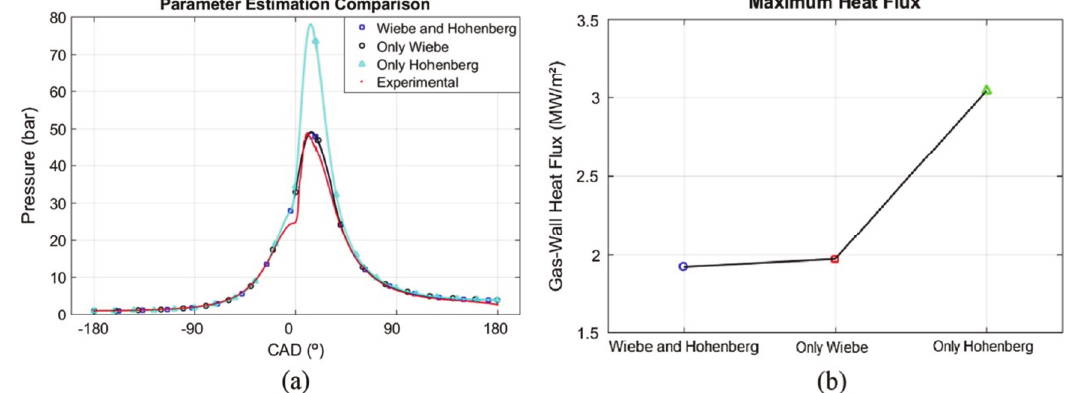
Fig. 6. Three cases estimation comparison using Hohenberg’s correlation for (a) the in-cylinder pressure and (b) the maximum heat flux